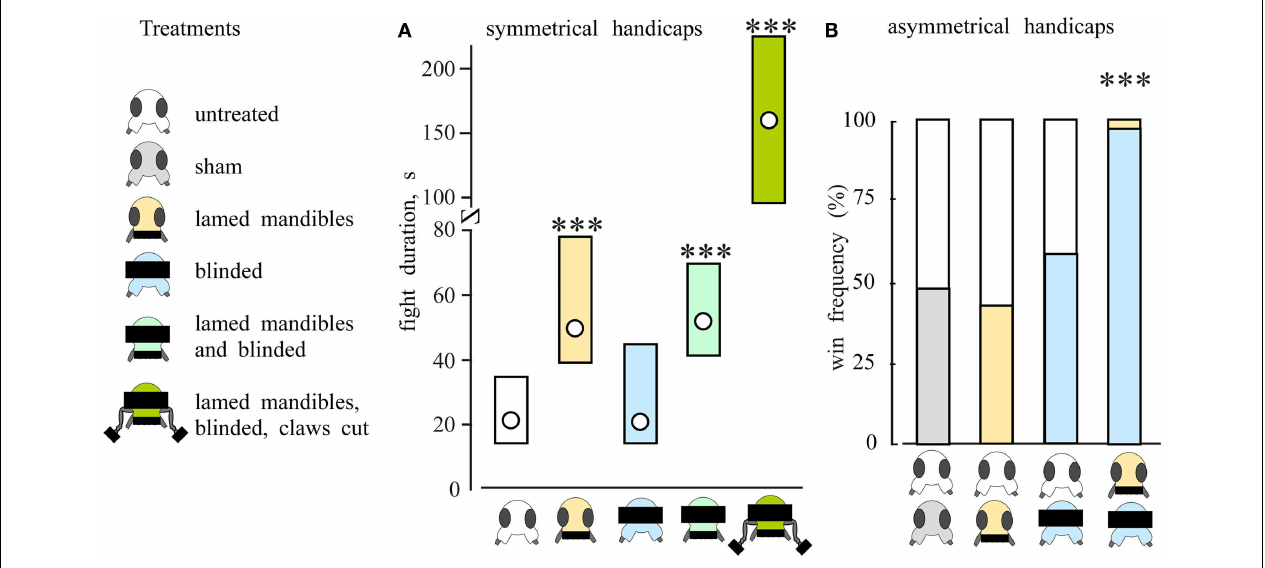
win frequencies (%) for handicapped crickets, from left to right: sham vs. untreated (n = 33); lamed mandibles vs. untreated, (n = 45) blinded vs. untreated ( n = 50), blinded vs. lamed mandibles (n = 35). Statistically significant differences between data sets are indicated [ (A) , U -test; (B) , Chi-square; *, **, ***: p < 0.05, 0.01, 0.001 respectively; adopted from Rillich et al.,